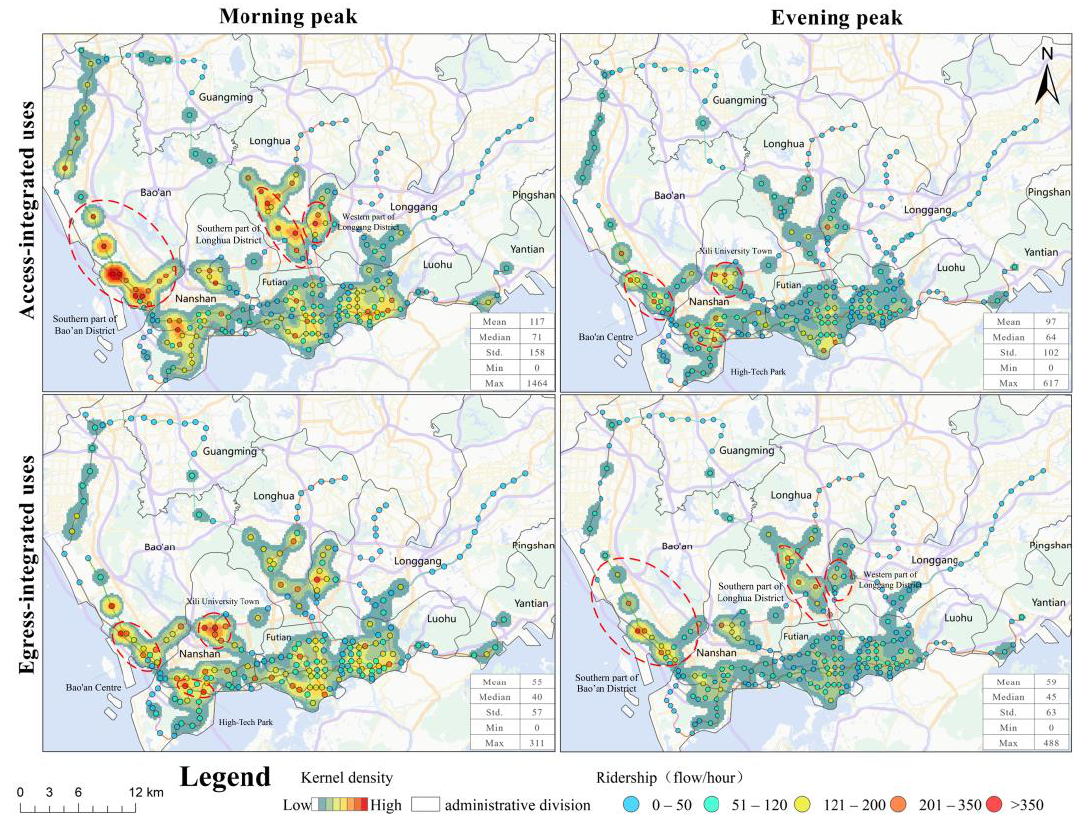
Figure 11. Morning and evening peak access use and egress use ridership statistics and kernel density distribution by metro station on weekdays.